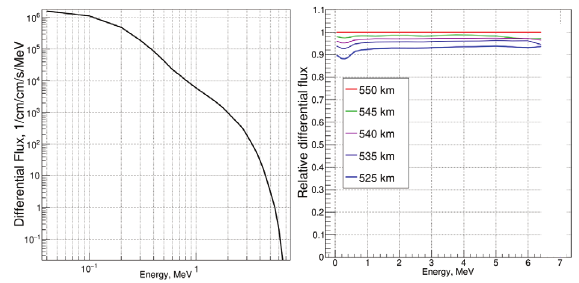
Figure 5: Left: Average di ff erential electron flux at 550 km height obtained with SPENVIS [8]. Right: Relative variation of the di ff erential electrons flux for di ff erent heights.